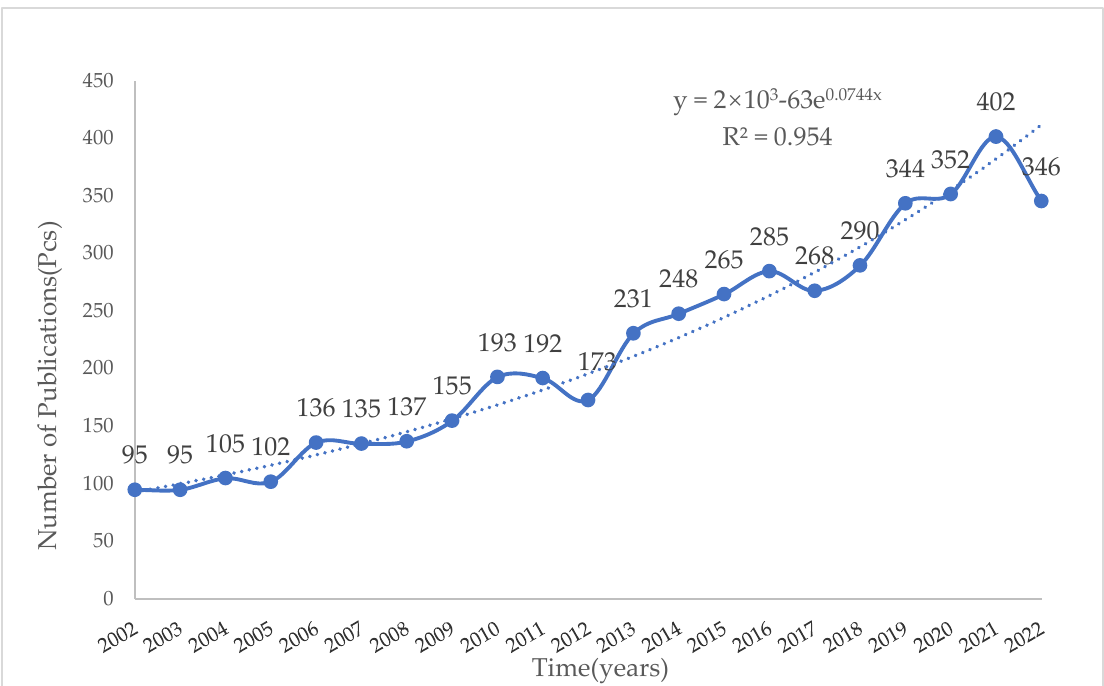
Figure 1. Statistical chart of the number of articles issued.